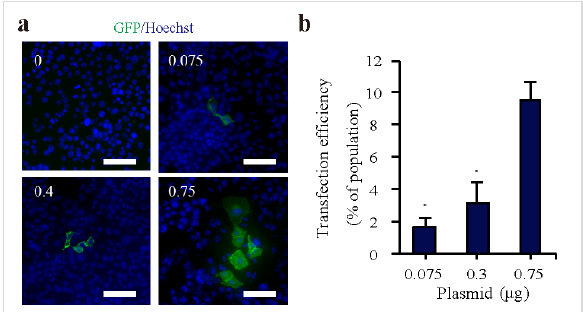
Figure 3: EGFP gene transfection into HL-1 cells using HAp nanoparti- cles. (a) Representative fluorescence images of HL-1 cells treated with HAp/pEGFP complexes. The nuclei were stained using Hoechst stain (blue). Scale bar: 100 µm. (b) The transfection efficiency of the com- plexes 24 h post-transfection. Values are presented as the mean ± SD ( n = 4). * p < 0.05.